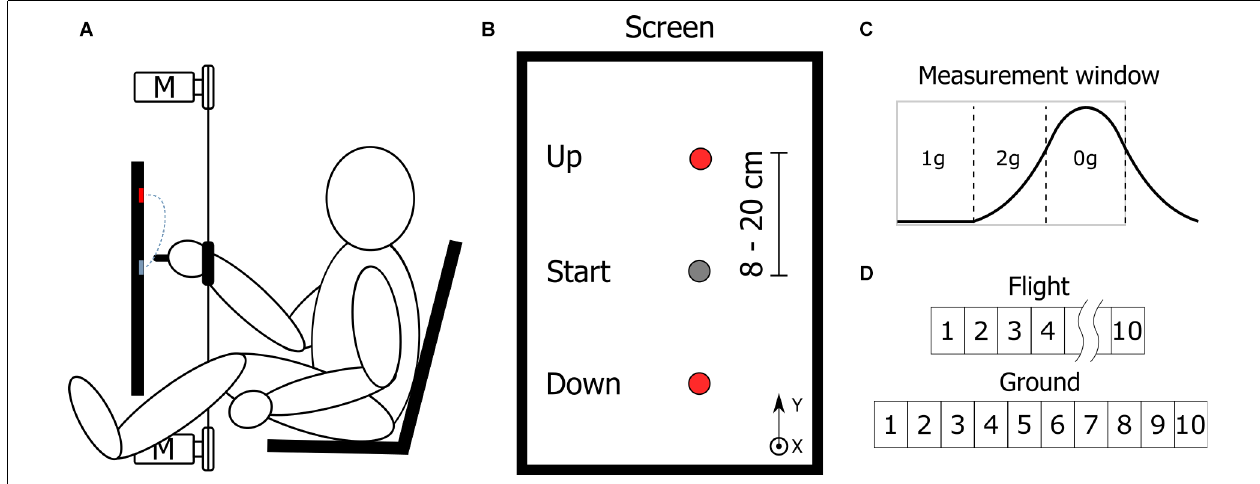
FIGURE 1 | (A) Profile view of the experimental setup and (B) view of the screen indicating start (Gray) and end target (Red) locations. The orientation of the coordinate system is marked indicating the positive y coordinate pointing up and the x coordinate pointing out from the screen towards the subject. (C) The measurement window during each parabola consisted of 20 s of normogravity followed by 20 s of hypergravity and finally 22 s of microgravity. (D) The number of parabolas per subject. The parabolas from 5 to 9 during flight were part of another